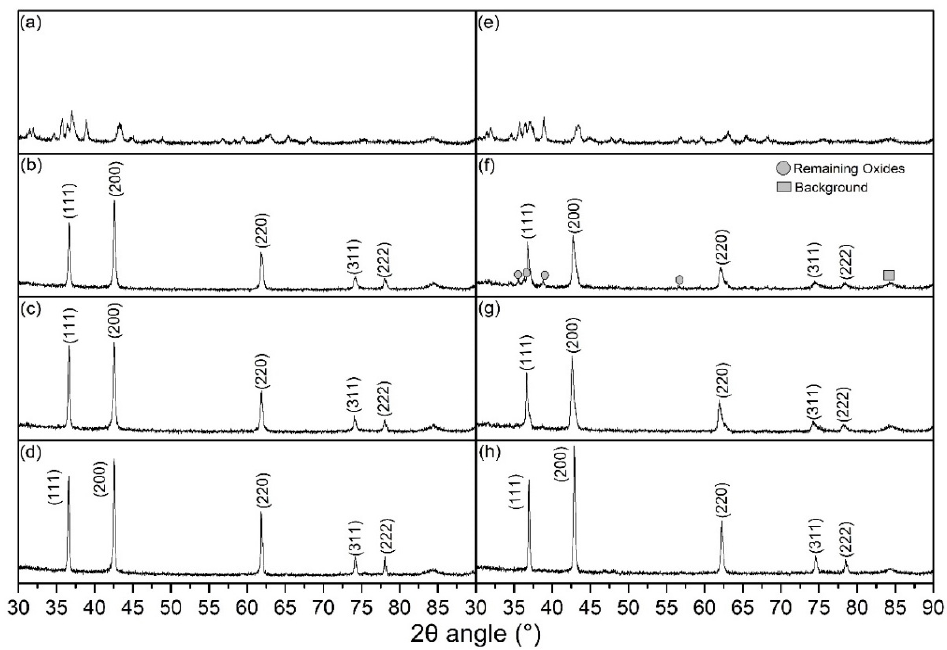
Figure 4. XRD spectra of ceramic samples sintered under different conditions: ( a ) 0.1Li green bodies; ( b ) 0.1Li, DC, 0.8 A; ( c ) 0.1Li, DC, 1 A; ( d ) 0.1Li, AC, 0.8 A; ( e ) 0.3Li green bodies; ( f ) 0.3Li, DC, 0.8 A; ( g ) 0.3Li, DC, 1 A; and ( h ) 0.3Li, AC, 0.8 A.